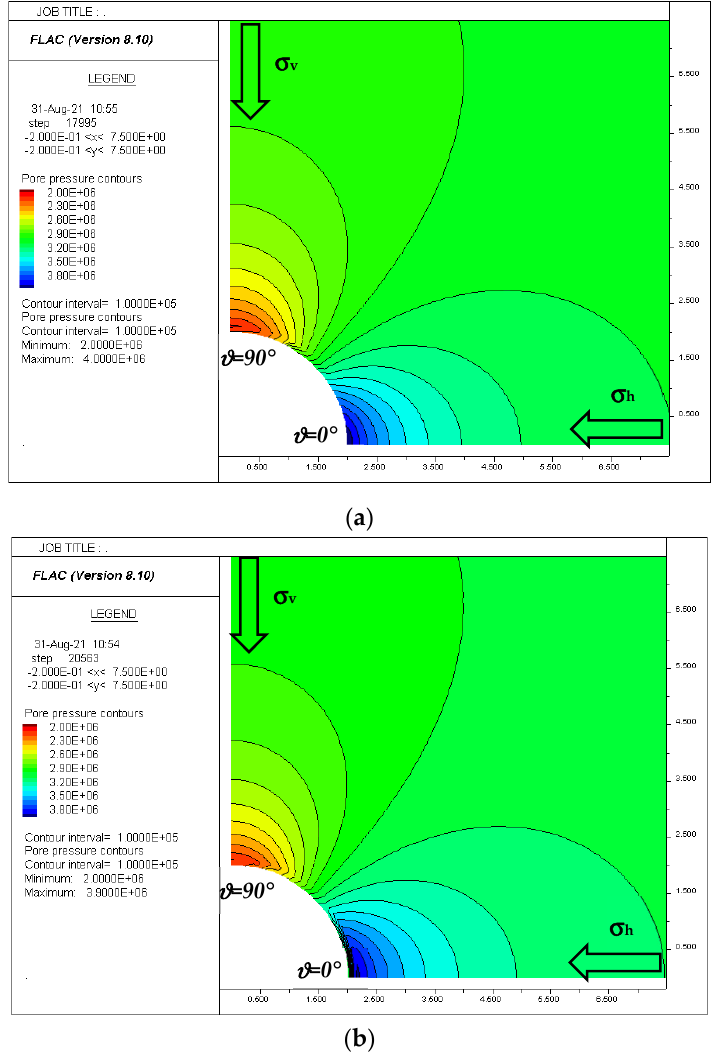
Figure 8. Numerical simulations of the undrained condition carried out with FLAC, when Δ u ≠ 0. Input data: P o = 0, K = 0.7, z ≈ 300 m, σ v = 7 MPa, σ h = 5 MPa S = 16 MPa, u ini = 3 MPa E u = 10 GPa ν u = 0.33, m t = 11.6 σ c = 36.6 MPa σ t = − 3.1 MPa: ( a ) Elastic; ( b )